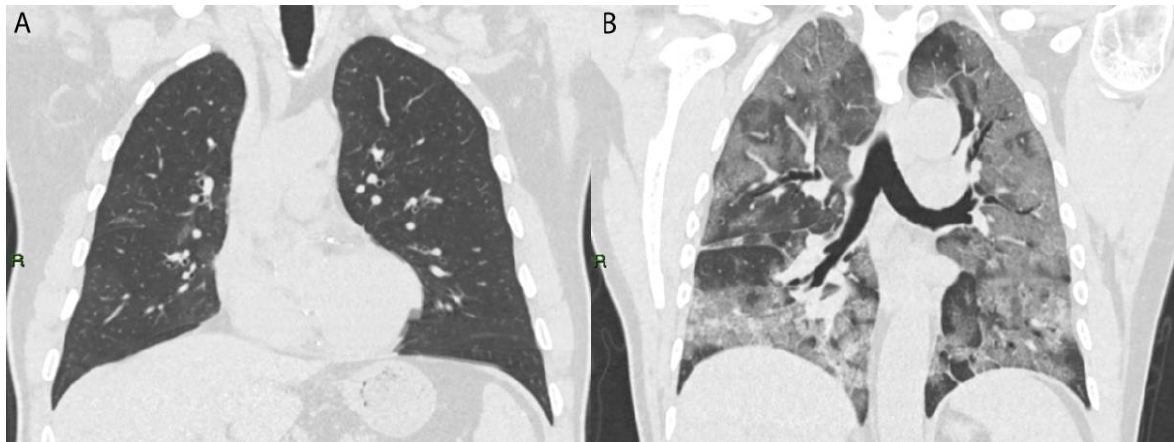
Figure 4. Coronal TC image of two COVID-19 patients: ( A ) patient with low CT score (5/25); ( B ) patient with high CT score (24/25).